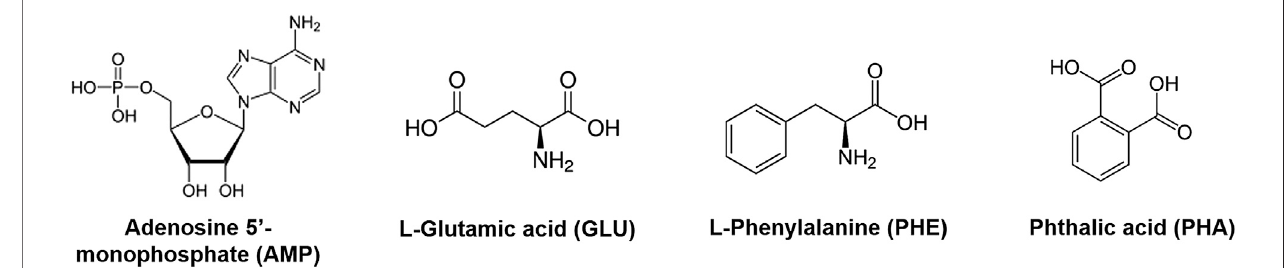
FIGURE 1 | Chemical structures for adenosine 5 ’ -monophosphate (AMP), L-glutamic acid (GLU), L-phenylalanine (PHE), and phthalic acid (PHA).